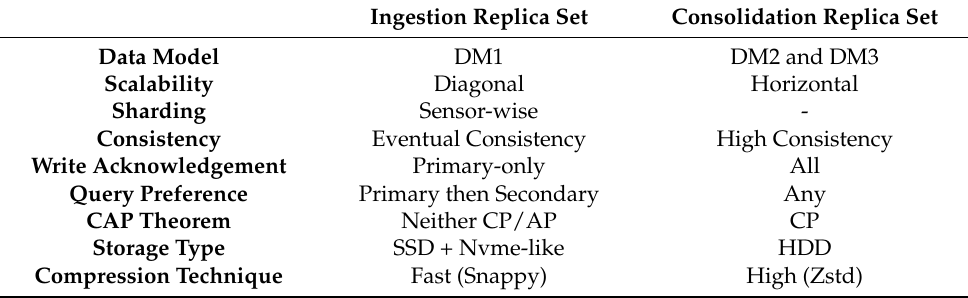
Table 1. Sum up of the scalability approach’s properties.